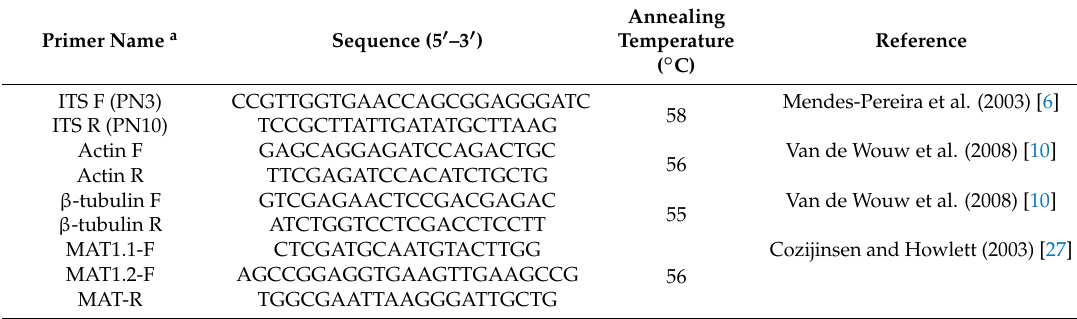
Table 2. Sequences of primer pairs used in PCR assays to confirm the identity of Leptosphaeria biglobosa and L. maculans isolates in this